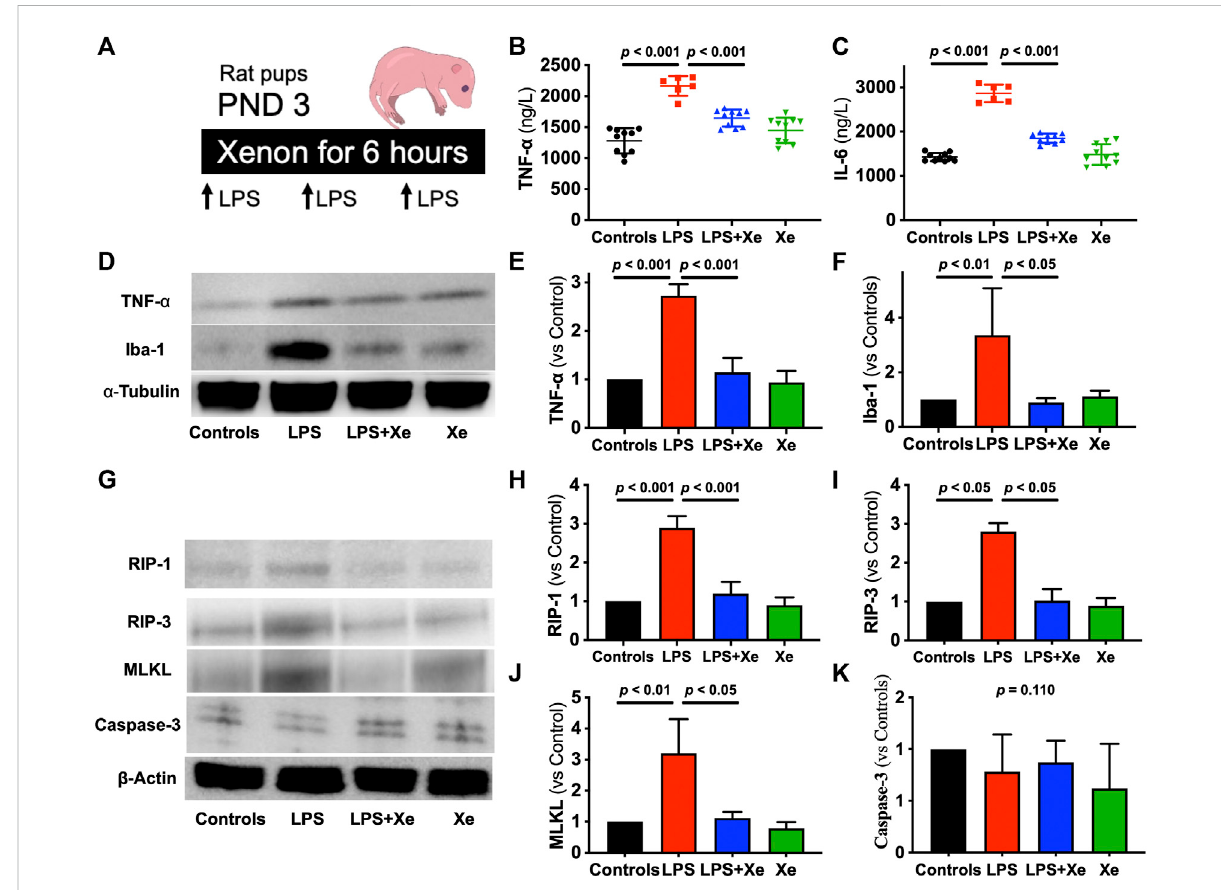
FIGURE 1 Xenon prevents LPS-caused acute systematic and neuronal in fl ammation in rat pups. Study Scheme (A) . Plasma level of TNF- a (B) and IL-6 (C) were measured 6 h after LPS injection plus gas exposure ( n = 10 in group Con, LPS + Xe and Xe; n = 6 in group LPS). Representative western blot images with quanti fi cation for acute neuroin fl ammation (D – F) and acute cell death (G – K) from the hippocampus. Data are expressed as mean ± SD ( n = 4in eachgroup). (Con =saline injection+70%N 2 /30%O 2 ;LPS =LPS injection+70%N 2 /30%O 2 ;LPS + Xe= LPSinhalation +70%Xenon/30% O 2 ; Xe = saline injection +70% Xe/30% O 2 ; PND = Post Neonatal